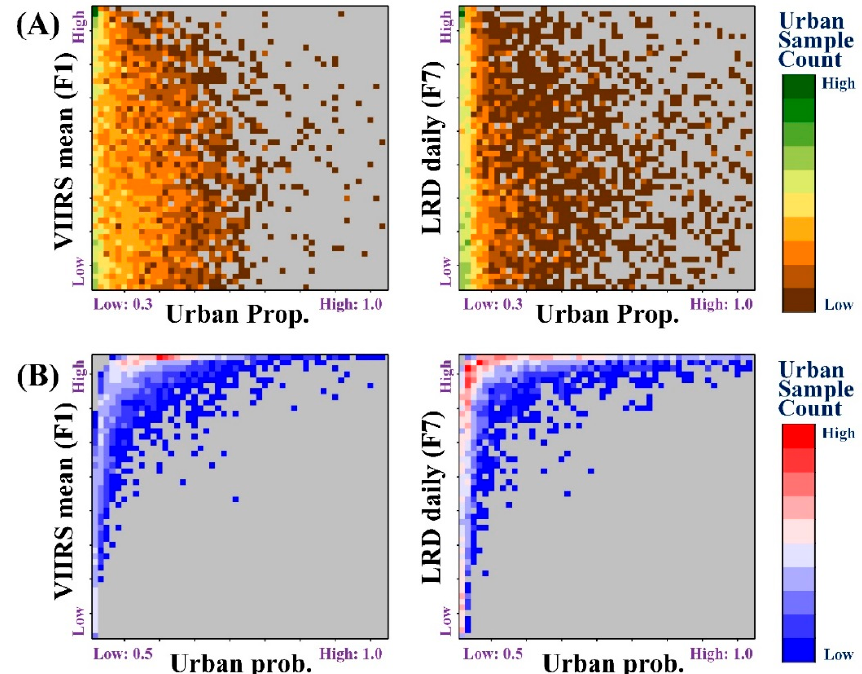
Figure 12. The heatmap between two most important features (F1 and F7) and two classification properties for all urban samples, including ( A ) urban proportion (prop.) for labeling and ( B ) RF urban probability (prob.). The color map shows the different urban sample counts.